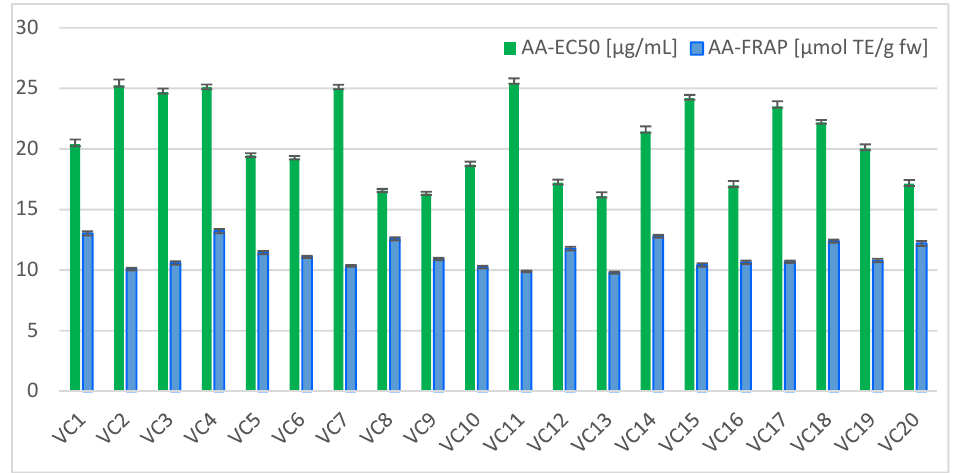
Figure 2. Antioxidant activity (AA) by DPPH (EC 50 ) and FRAP assays in fruits of 20 black mulberry ( M. nigra ) genotypes (VC1–VC20).